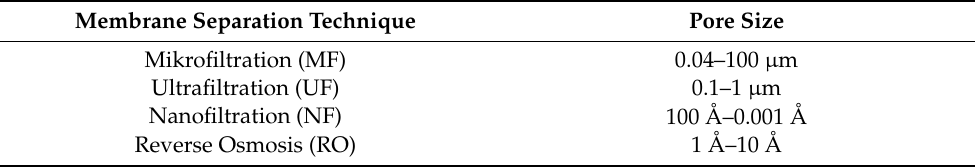
Table 1. Membrane separation technique and pore